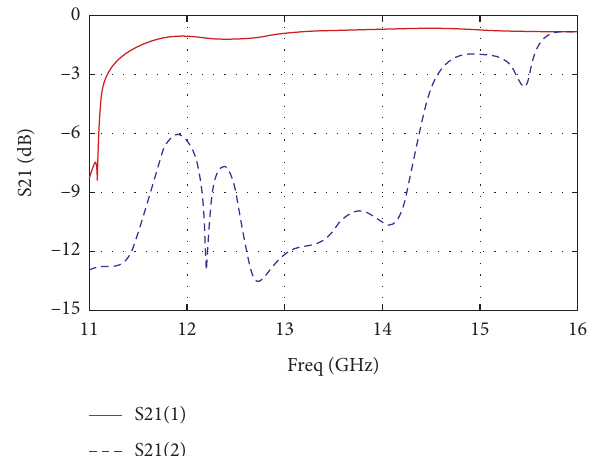
Figure 4: Transmission efficiency of the first two modes (with (1) and (2) represent E y